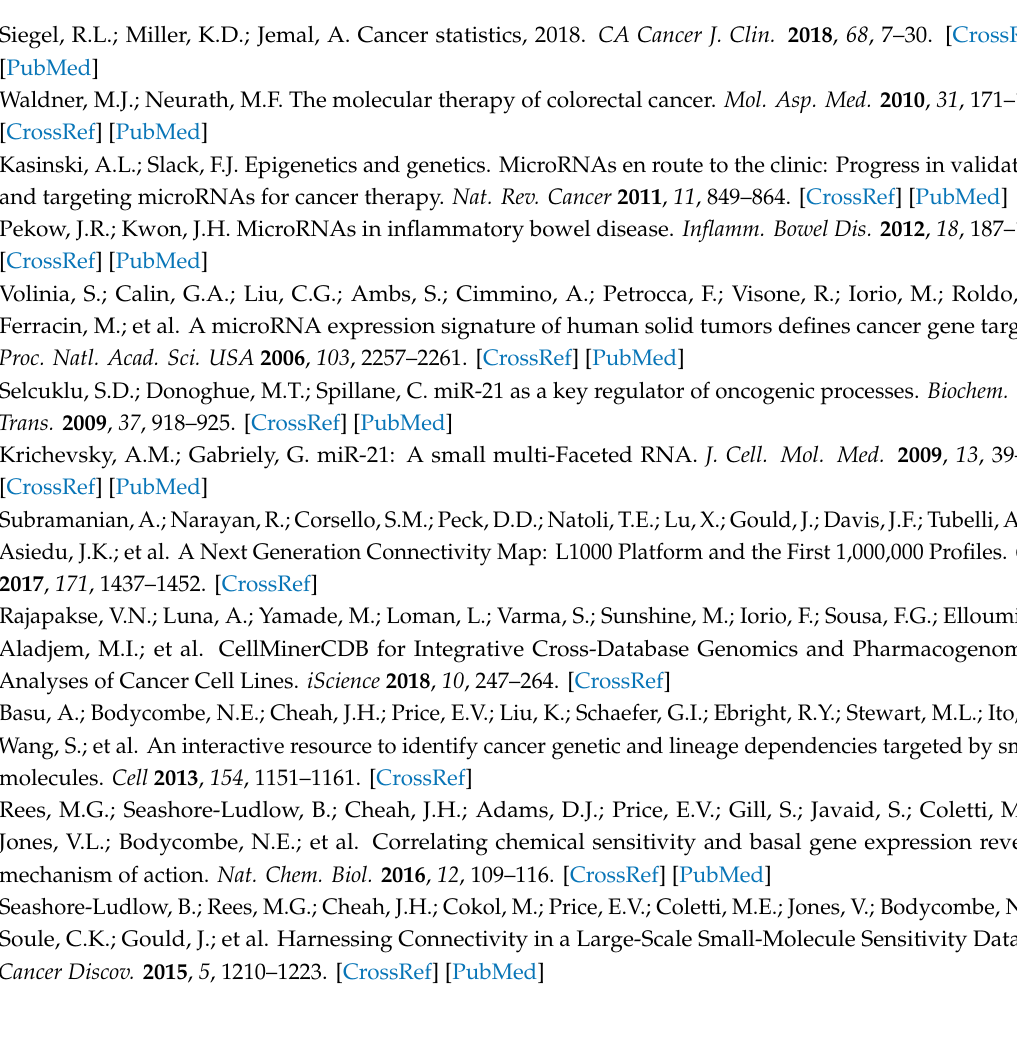
Figure S1: The correlation between drug activity and gene expression, Figure S2: The e ff ect of VP-16 on miR-21 expression, Figure S3: Uncropped images of the blots, Table S1: Gene list for the Connectivity Map (CMap) analysis, Table S2: Gene list for KEGG proteasome pathway mapping, File S1: Di ff erentially expressed genes in DLD-1-miR-21 vs. DLD-1-vector